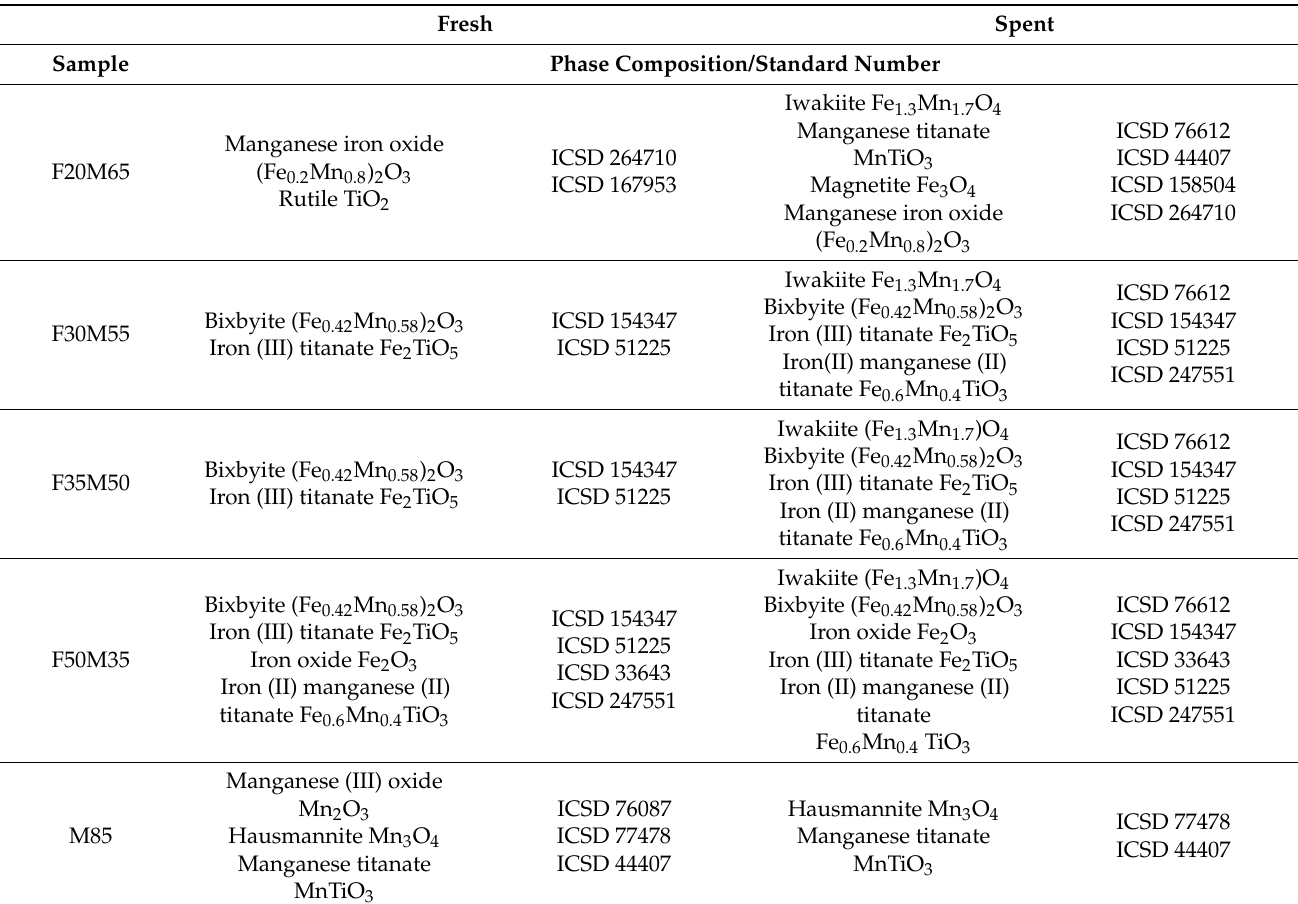
Table 1. Phase composition of as-synthesized and spent OCs.